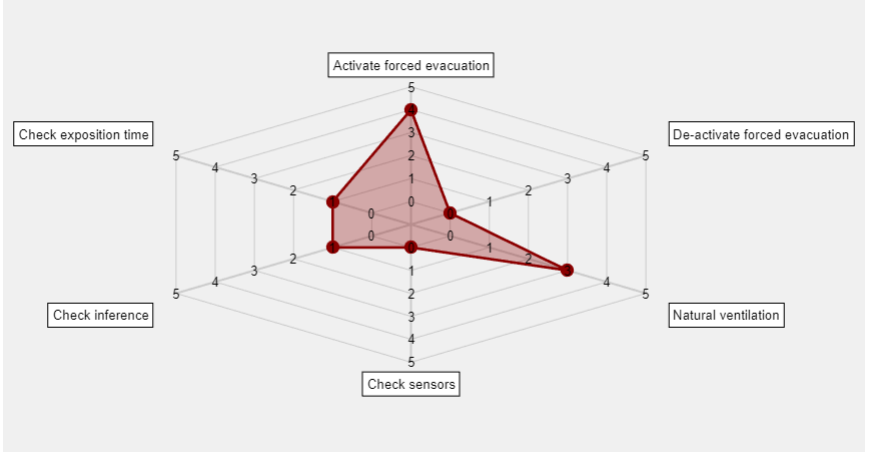
Figure 2. Example of a recommendation diagram.